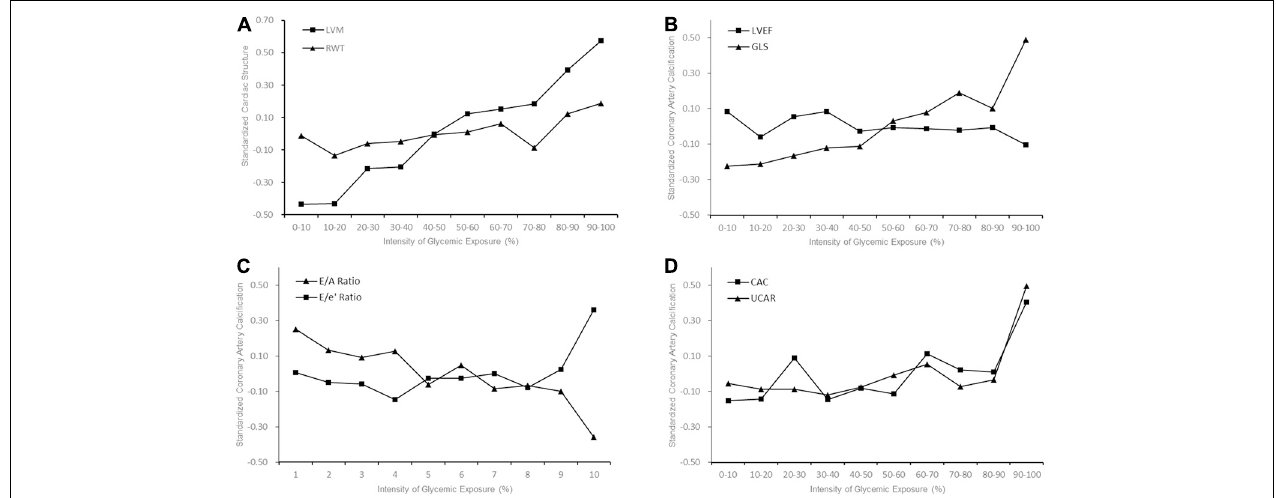
FIGURE 1 | Early Adulthood Intensity of Glycemic Exposure and Middle-Age Target Organ Function. The trajectory slopes showed indices of target organs function with increasing decile of intensity of glycemic exposure (IGE). (A) Cardiac structure; (B) Left ventricular (LV) systolic function; (C) LV diastolic function; (D) Coronary artery calcium (CAC) and albuminuria. Higher deciles of IGE produced higher level of left ventricular mass (LVM) (A) , global longitudinal strain (GLS), CAC and urine albumin to creatinine ratio (UACR).